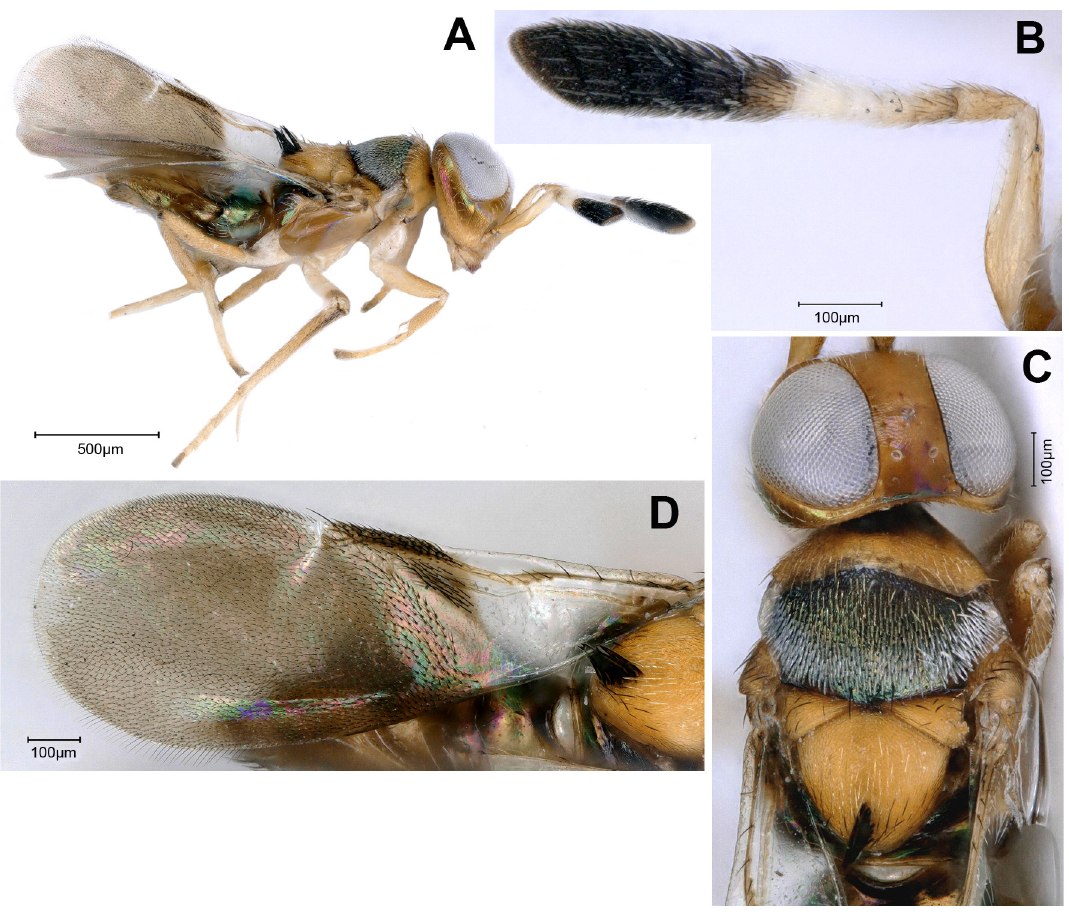
Fig. 3. Cheiloneurus paralia (Walker, 1837). A . Female in lateral view. B .Antenna of female. C . Head, pronotum, mesoscutum and mesoscutellum in dorsal view. D . Fore